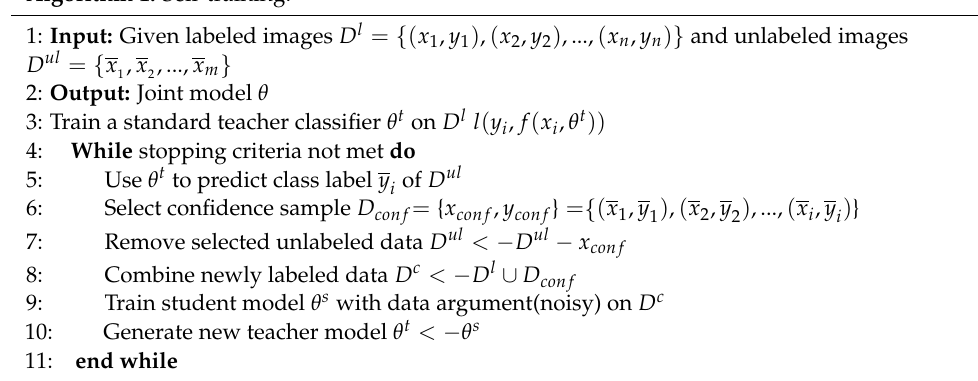
Algorithm 1. Self-training.